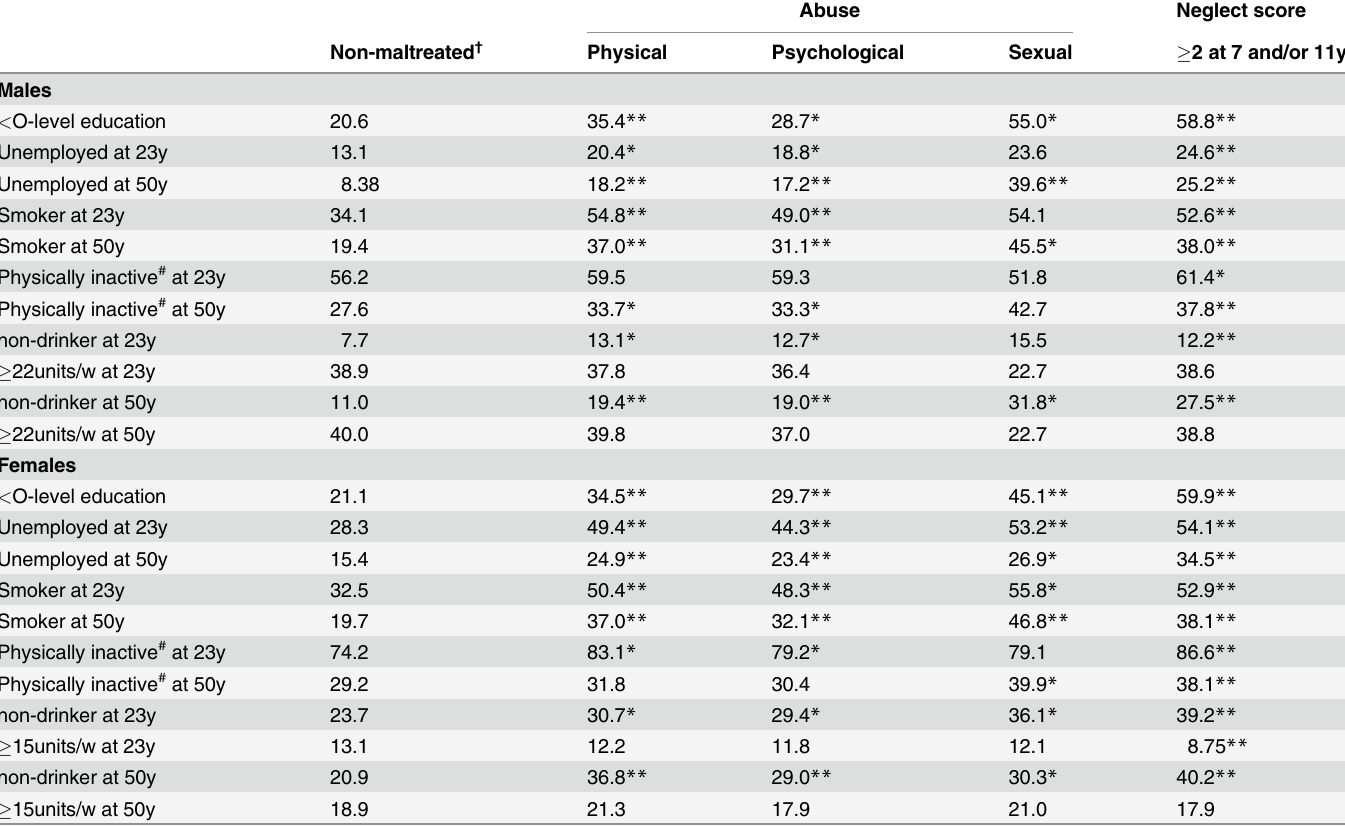
Table 3. Characteristics of those with no childhood maltreatment † and those abused or neglected